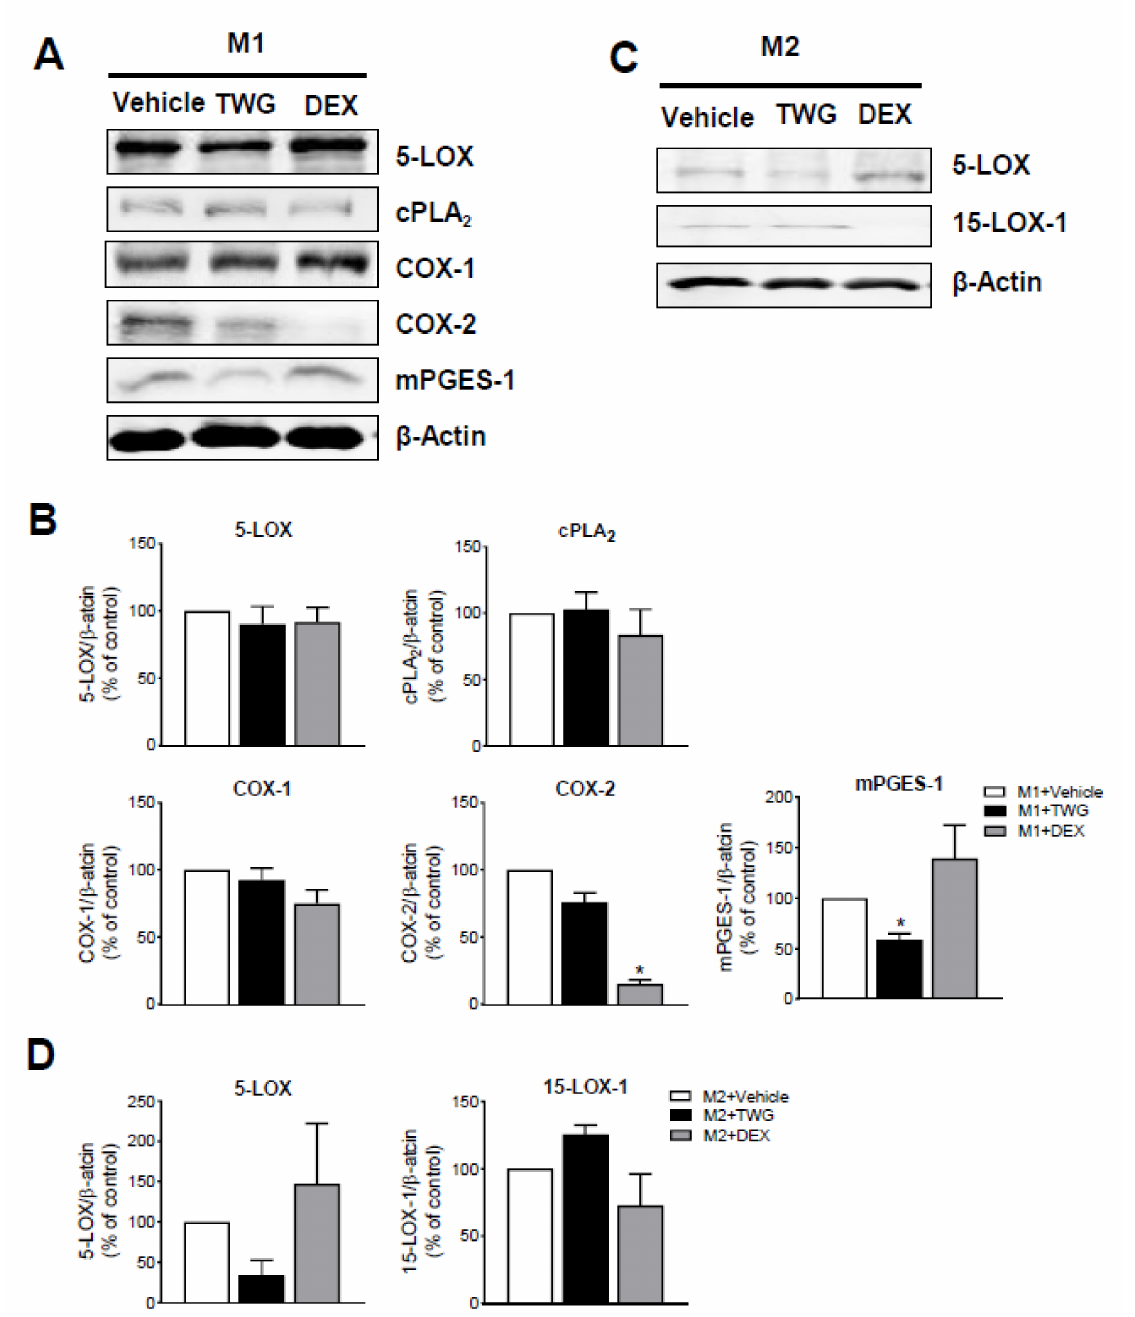
Figure 5. Effects of TWG on LM-biosynthetic enzyme expression during polarization of human M1- and M2-MDM. Human monocytes were differentiated towards M0 macrophages using GM-CSF or M-CSF for 6 days. These M0 GM-CSF and M0 M-CSF were pretreated for 15 min with 1 µ g/mL TWG, 100 nM dexamethasone (DEX) or 0.1% DMSO as vehicle and then polarized for 48 h towards M1-MDM using LPS plus IFN γ or towards M2-MDM using IL-4, respectively. ( A – D ) Protein expression in lysates of M1-MDM ( A , B ) and M2-MDM ( C , D ) were analyzed by Western blotting. For densitometric analysis ( B , D ), 5-LOX, cPLA 2 , COX-1, COX-2 and mPGES-1 proteins were normalized to β -actin; exemplary results ( A , C ) are shown as means + S.E.M. from n = 3 separate donors (both M1-MDM and M2-MDM). Values shown are percentages of DMSO controls (=100%). Densitometric ratios were used for statistical analysis, * p < 0.05, TWG vs. control group, one-way ANOVA and Dunnett’s multiple comparisons